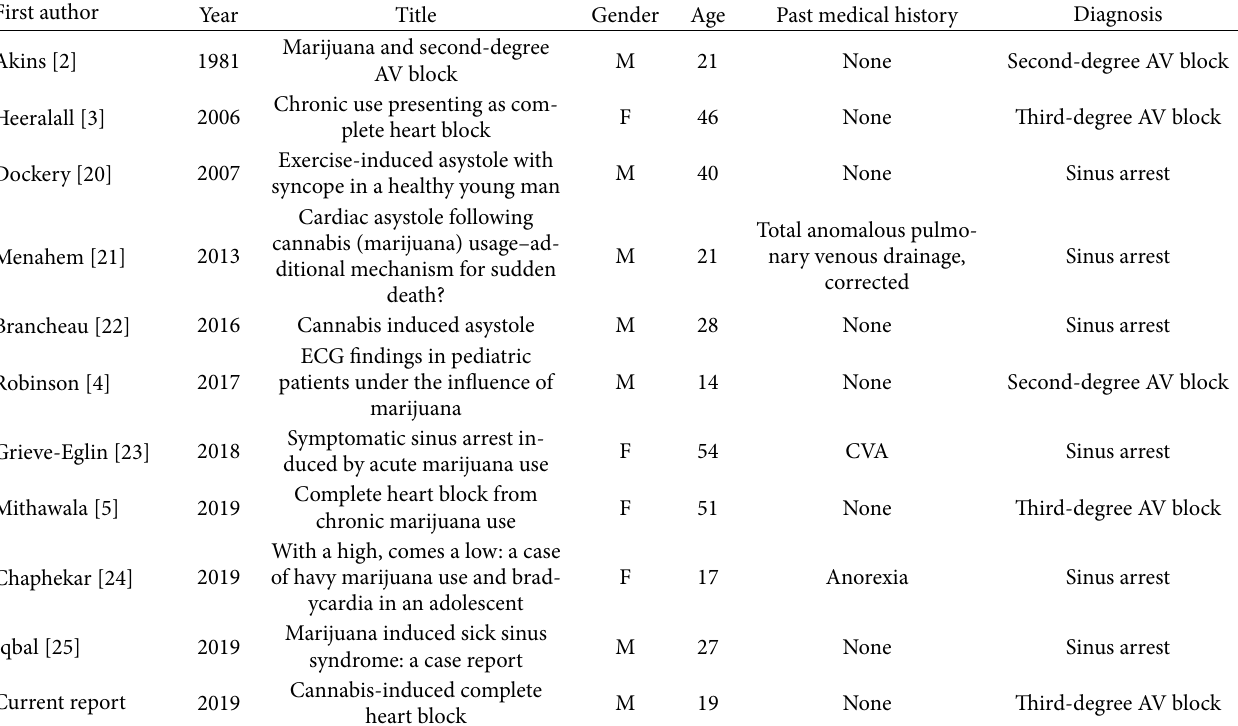
Table 1: Published cases of documented bradycardia linked to cannabis